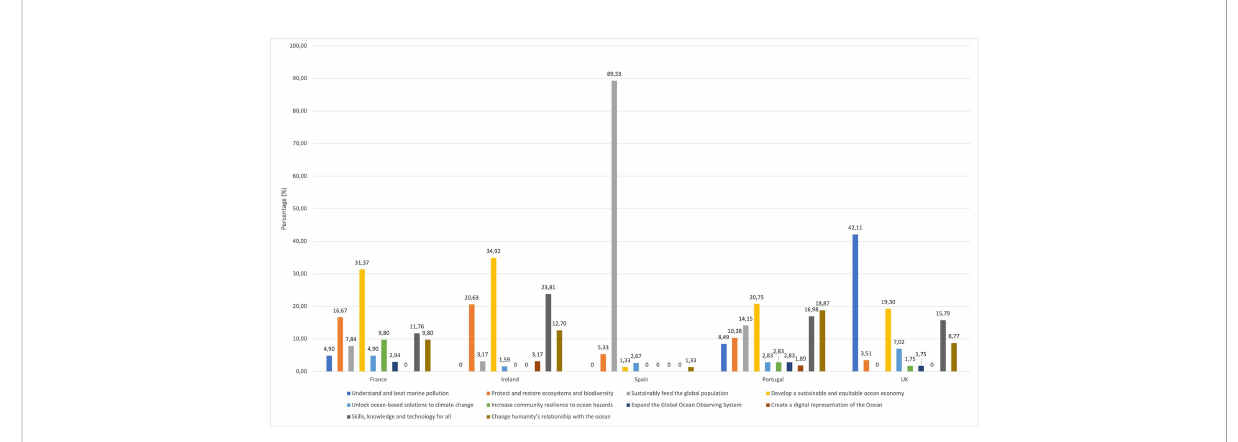
FIGURE 13 Percentage of measures of the fi ve National Ocean Strategies analyzed according to the 10 key challenges of the United Nations Decade of Ocean Science for Sustainable Development. Source: Created by the